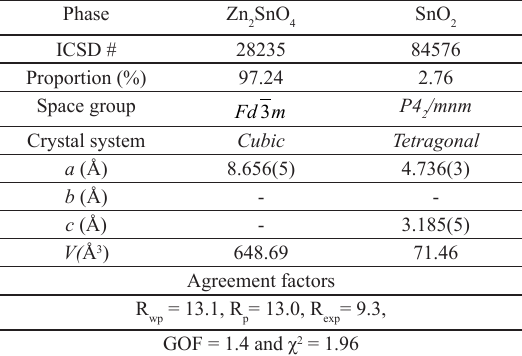
Table 2. Crystallographic and Rietveld refinement parameters for Zn